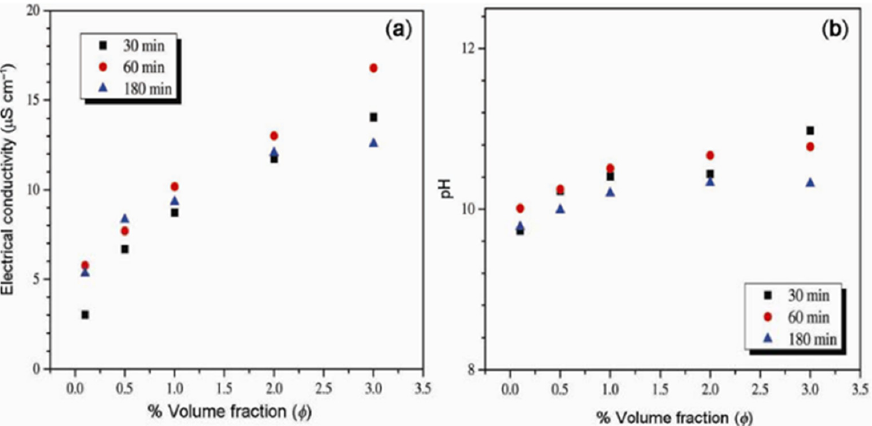
Figure 10. Influence of sonication time on the electrical conductivity and pH of MgO-EG NF at 20 °C: ( a ) electrical conductivity and ( b ) pH. Adapted from [120]. ( a ) electrical conductivity and ( b ) pH. Adapted from